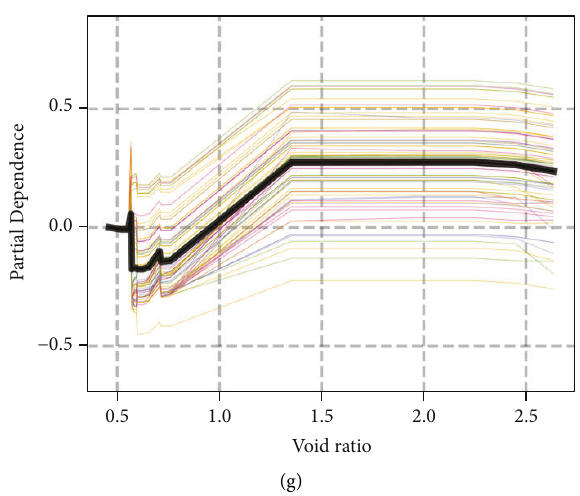
Figure 7: Individual conditional expectation of each feature on the permeability coefficient of